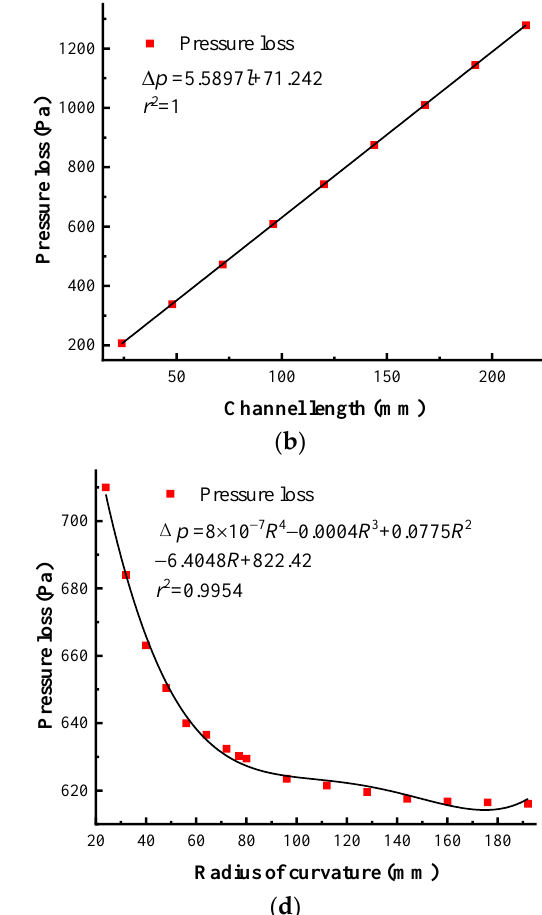
( b ) Figure 4. ( a ) A schematic of the pressure loss test rig; ( b ) a photo showing the test rig. 4. Results and discussion 4.1. Relationship between Design Parameters of Flow Channels and Pressure Loss Figure 5 shows the relationship curves between  p and D , l , v and R , which were